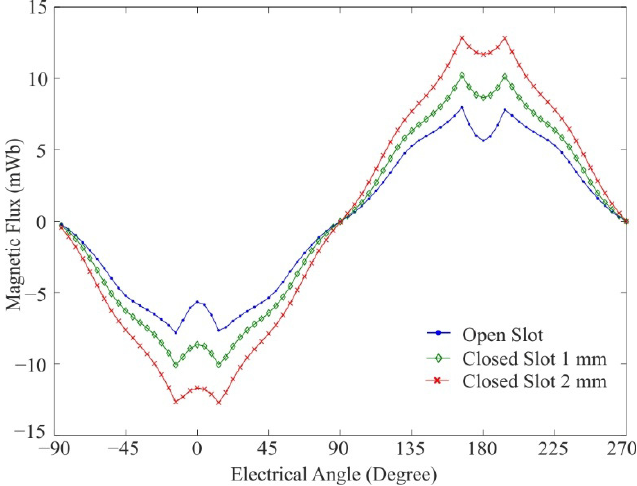
Figure 8. Magnetic flux leakage through one slot and in the air-gap for: open slot (dot); closed slot 1 mm thick (diamond); and closed slot 2 mm thick (cross), simulated over one magnetic pole